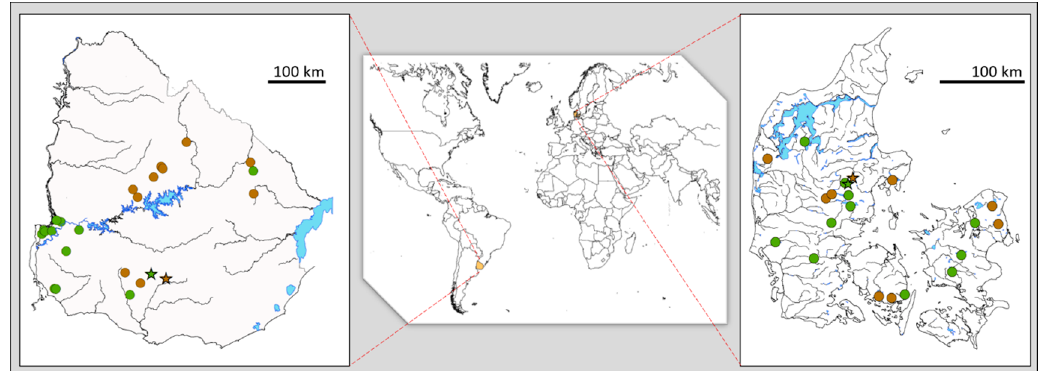
Figure 1. The geographic location of sampled streams. Left: subtropical/Uruguayan streams. Right: temperate/Danish streams. Circles: Snapshot grab-sampling. Stars: Benchmark streams. Green: high-